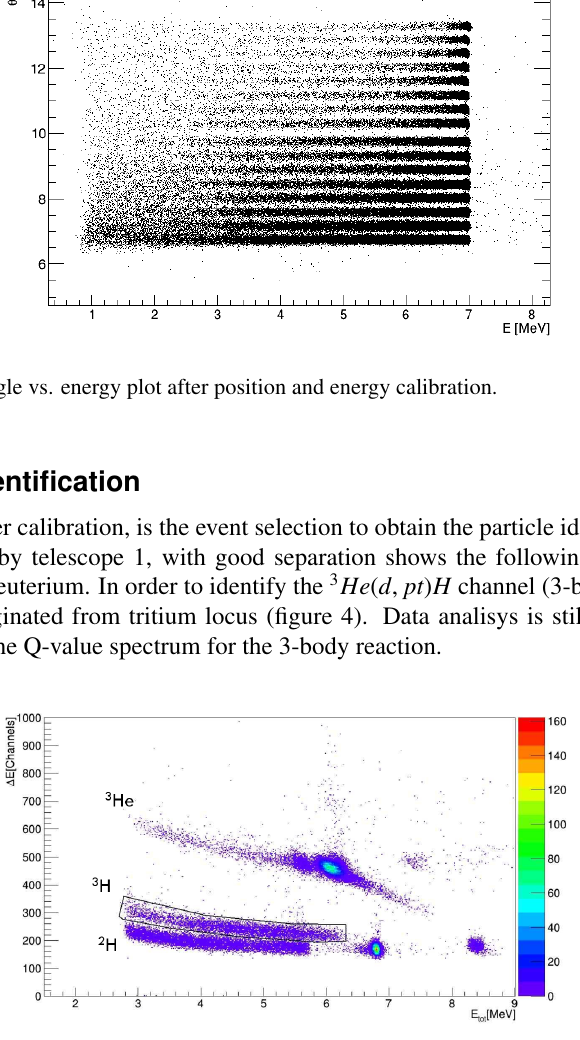
Figure 4. Δ E-E plot for particle identification. Tritons data have been gated with a graphical cut on this plot, shown as a solid